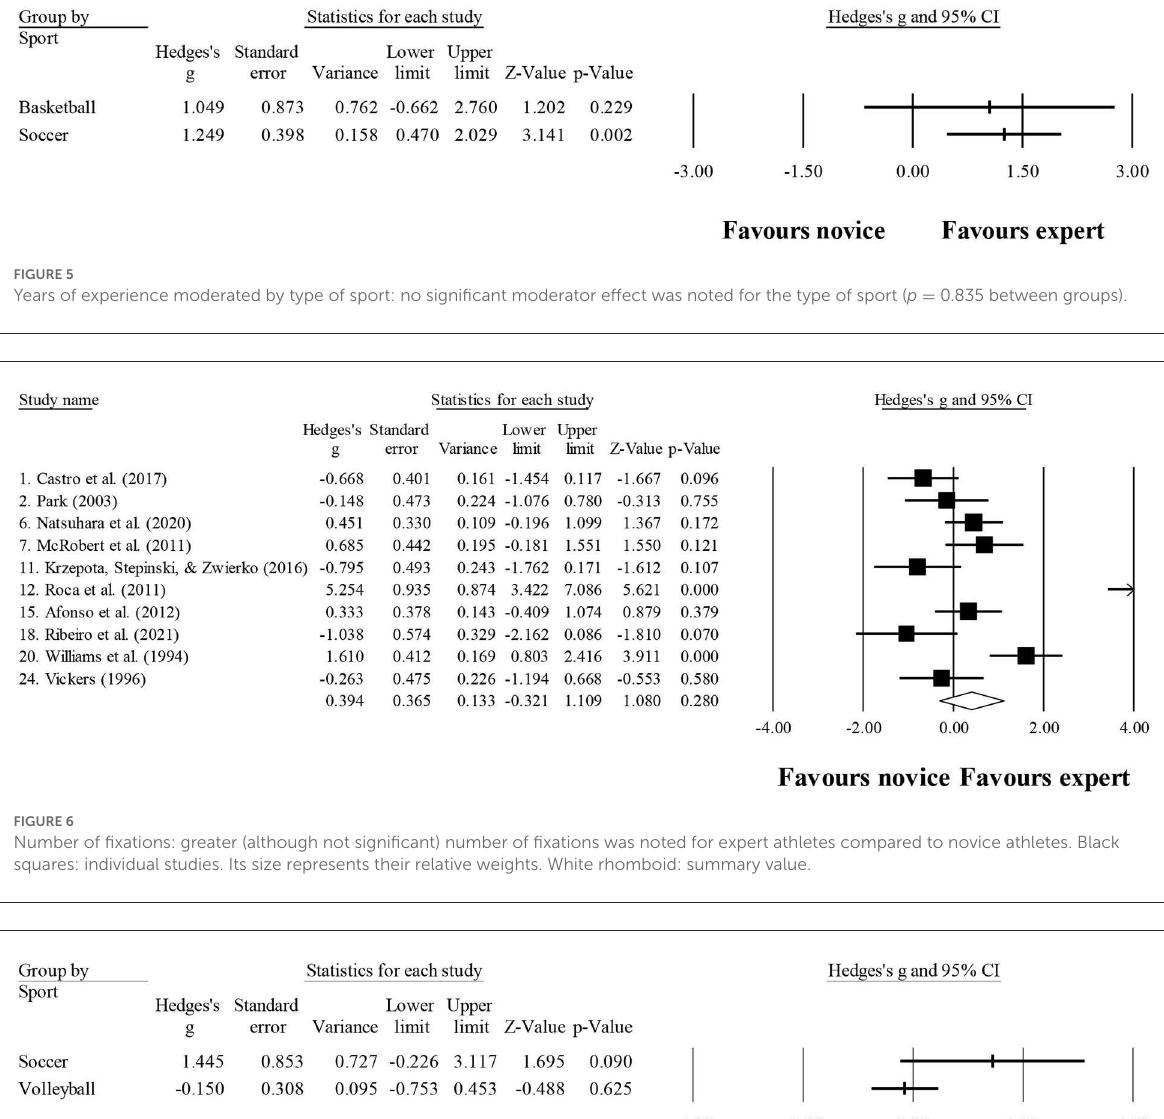
Figure 3; I 2 = 73.9%; Egger test = 0.007, with adjusted value at ES = 1.21, 95% CI = 0.76–1.65). When results were analyzed as per athletes’ involvement in their respective sports (Figure 4), no significant moderator effect was noted for the type of sport ( p = 0.835 between